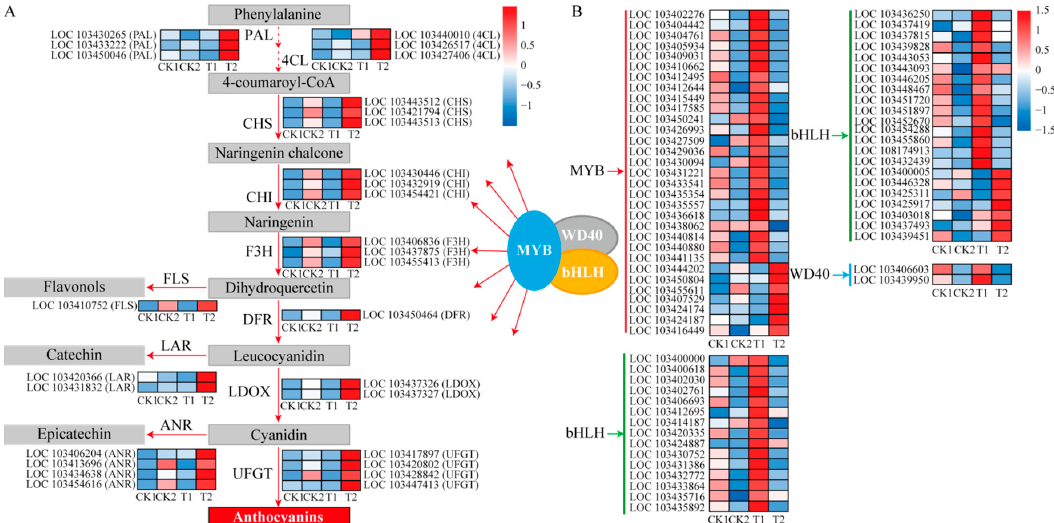
Figure 4. Simplified scheme and heat map of the expression of genes related to anthocyanin biosynthesis in “Granny Smith” apple skins. ( A ) Structural gene expression in “Granny Smith” apple skins. Straight-line and dashed-line arrows indicated continuous and discontinuous steps, respectively. ( B ) Regulatory gene expression in “Granny Smith” apple skins. Arrows with different colors indicated different regulatory genes. PAL, phenylalanine ammonia lyase; 4CL, 4-coumarate coenzyme A ligase; CHS, chalcone synthase; CHI, chalcone isomerase; F3H, flavanone 3-hydroxylase; DFR, dihydroflavonol-4-reductase; LDOX, leucoanthocyanidin dioxygenase; UFGT, UDP-glucose: flavonoid-3- O -glucosyltransferase; FLS, flavonol synthase; LAR, leucoanthocyanidin reductase; ANR, anthocyanidin reductase. Enzyme names, gene IDs, and expression patterns are indicated at the side of each step. The color scale on the right represents the log-transformed Fragments Per Kilobase of transcript per Million (FPKM) value.